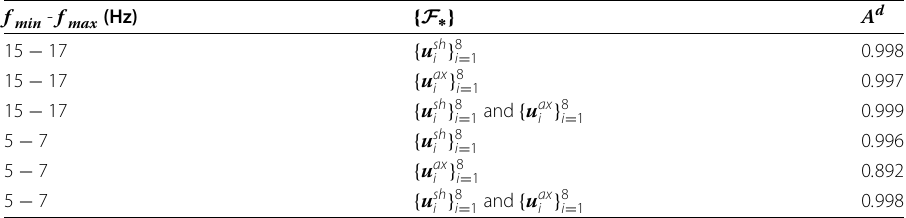
Table 5 Damage detection, case 2